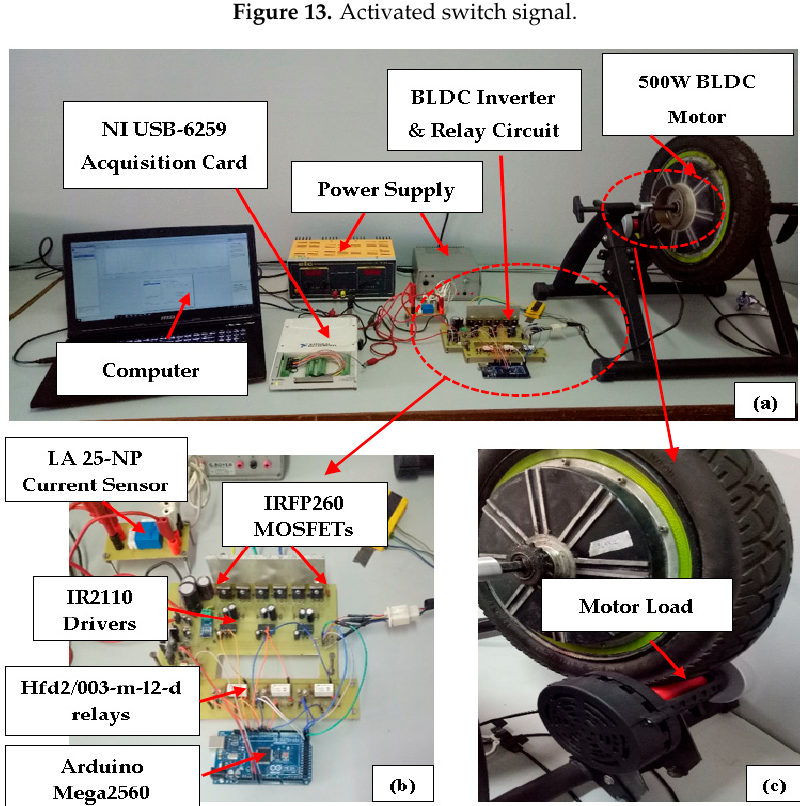
Figure 14. Experimental test rig for BLDC motor control: ( a ) Global test-rig, ( b ) BLDCM inverter, ( c ) motor load.